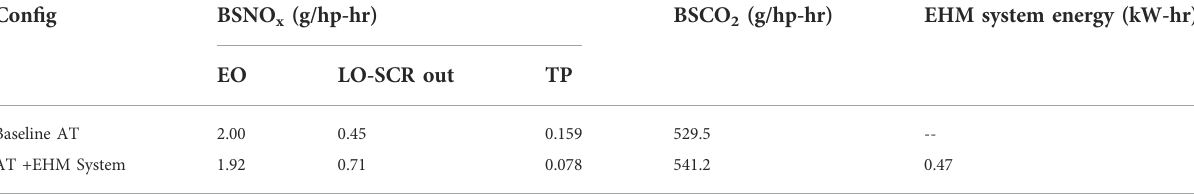
TABLE 3 Cold FTP test